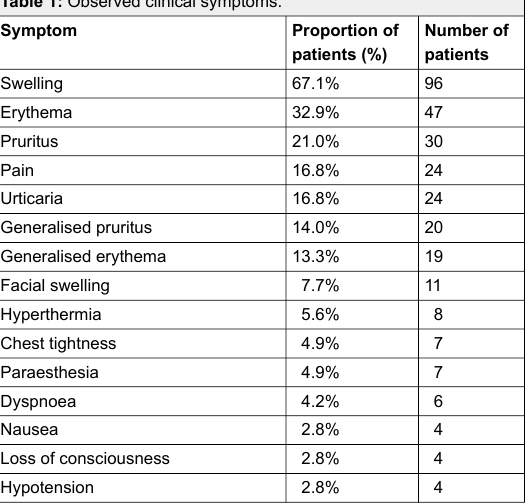
Table 1: Observed clinical symptoms.